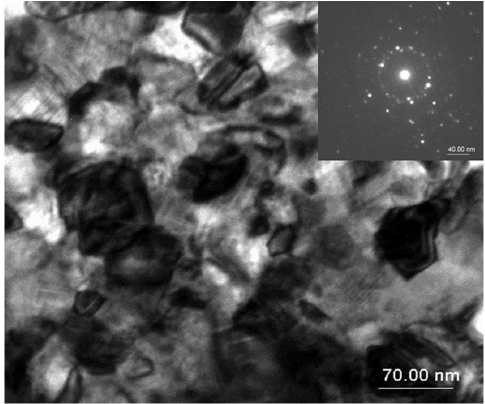
Figure 5. TEM image and corresponding EDP for the sample annealed at 800 °C.